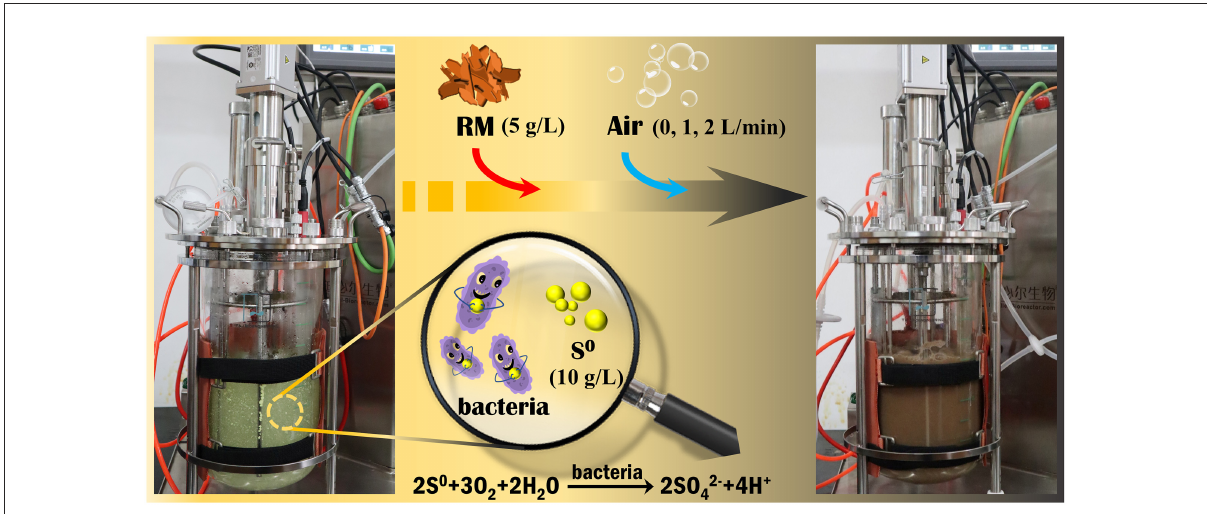
FIGURE1 Experimental setup for bioleaching of valuable metals from RM by Sb. thermosulfidooxidans in a 5-L